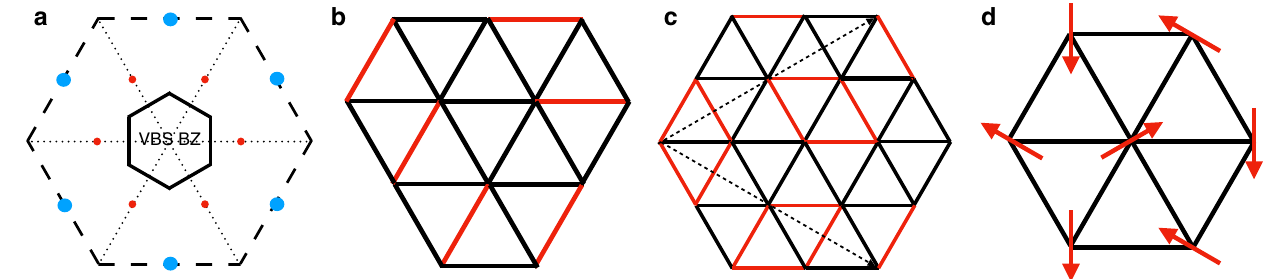
Fig. 2 Triangular lattice VBS and magnetic orders. a The reduced brioulin zone (BZ) stipulated by the momenta of V 1 ; 2 ; 3 ; (cid:1) ψτ 1 ; 2 ; 3 ψ which has an area 1/12 of the original one. The red/blue dots mark momenta of V i ’ s and (cid:1) ψτ 1 ; 2 ; 3 ψ , respectively. b One particular VBS pattern inside a 12-site unit cell used in previous numerics for quantum dimer models which can result from any generic (cid:1) ψτ i ψ and subsequent monopole proliferation, so long as they break all but the enlarged VBS Bravais lattice translations. Red/black bonds denote positive/vanishing valence bond weight. c A more symmetric VBS, invariant under C 3 around the blue dot. d The 120° magnetic order induced by mass (cid:1) ψσ 3 ψ ð M 30